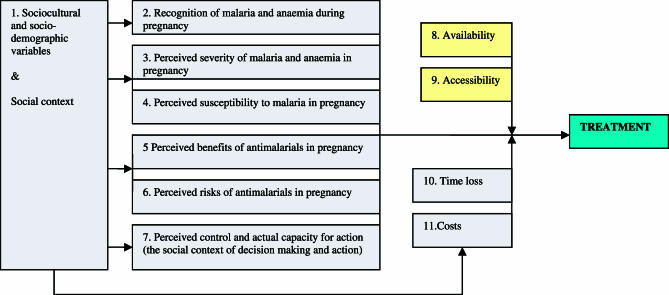
The Malaria in Pregnancy Treatment Model: Relevant Factors for Treatment-Seeking Behaviour for Malaria in Pregnant Women